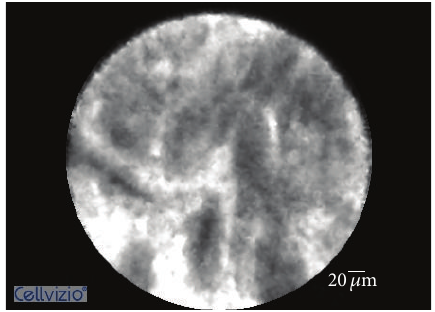
Figure 1: Probe-based confocal laser endomicroscopy imaging showing multiple thin white bands.